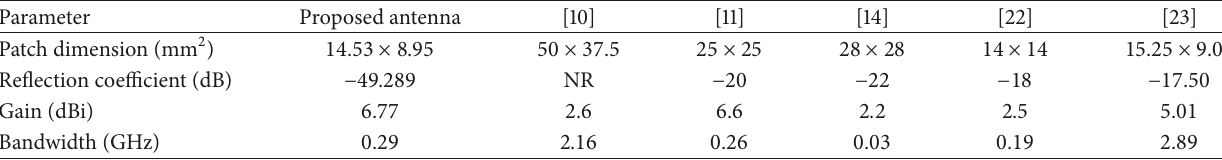
Table 3: Performance comparison of the proposed antenna with other existing